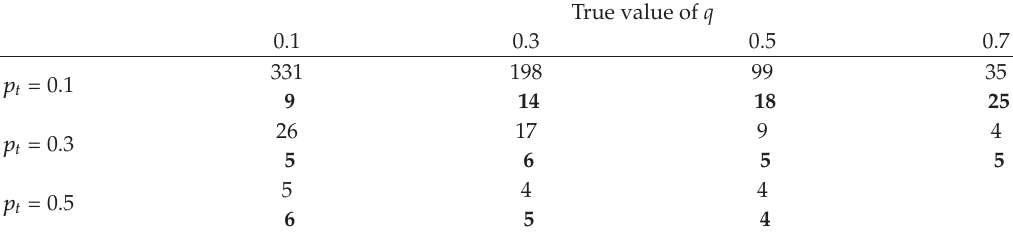
Table 2: MSE times 1000 for the methods of moments estimate of q for models which are not detrended (cid:2) top row (cid:3) and detrended (cid:2) bottom row—bold face type (cid:3) . True value of q 0.1 0.3 0.5